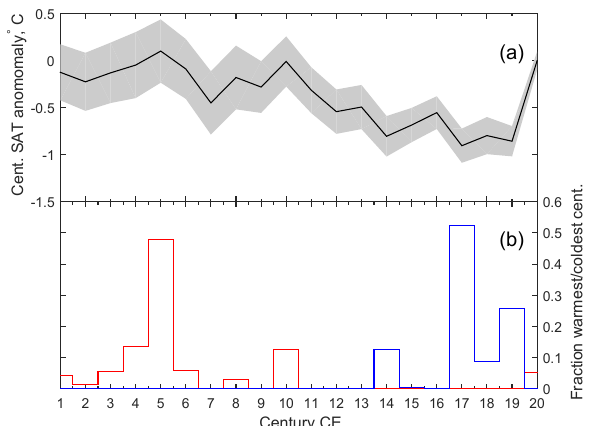
Figure 4. (a) Ensemble-averaged century and spatial mean Arctic SAT (solid black) with the respective 95% CI highlighted in grey. (b) Mean Arctic SAT ensemble-based fraction warmest (red) and coldest (blue)